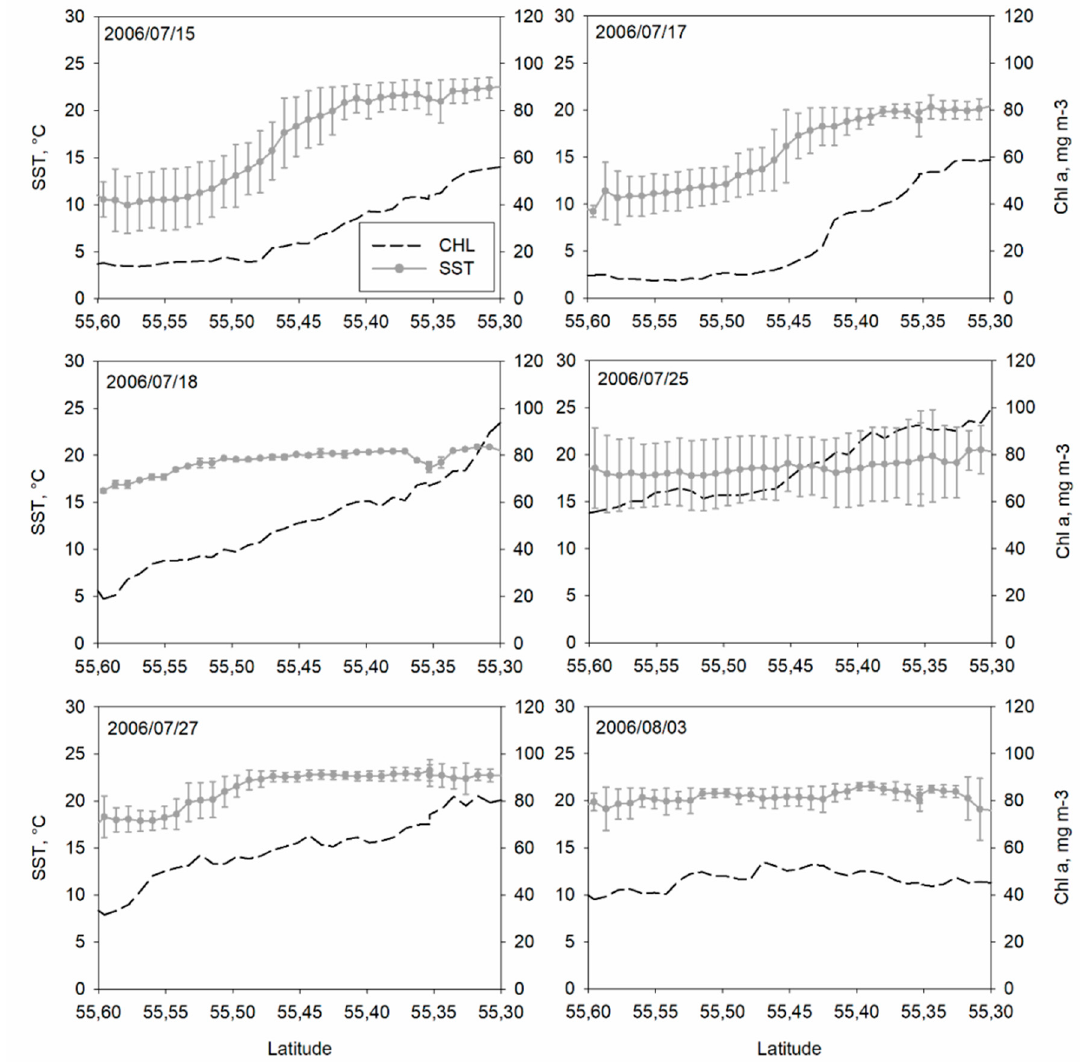
Figure 15. Spatial distribution of SST and the chl-a concentration along the transect in the Curonian Lagoon (shown on Figure 1) during the major upwelling event in the summer of 2006. The grey line with circles indicates the mean SST derived from the Moderate Resolution Imaging Spectroradiometer (MODIS)/Aqua and MODIS/Terra images of the day, and the error bars indicate the standard deviation of the SST. The black dashed line shows the chl-a concentration derived from the MERIS data.